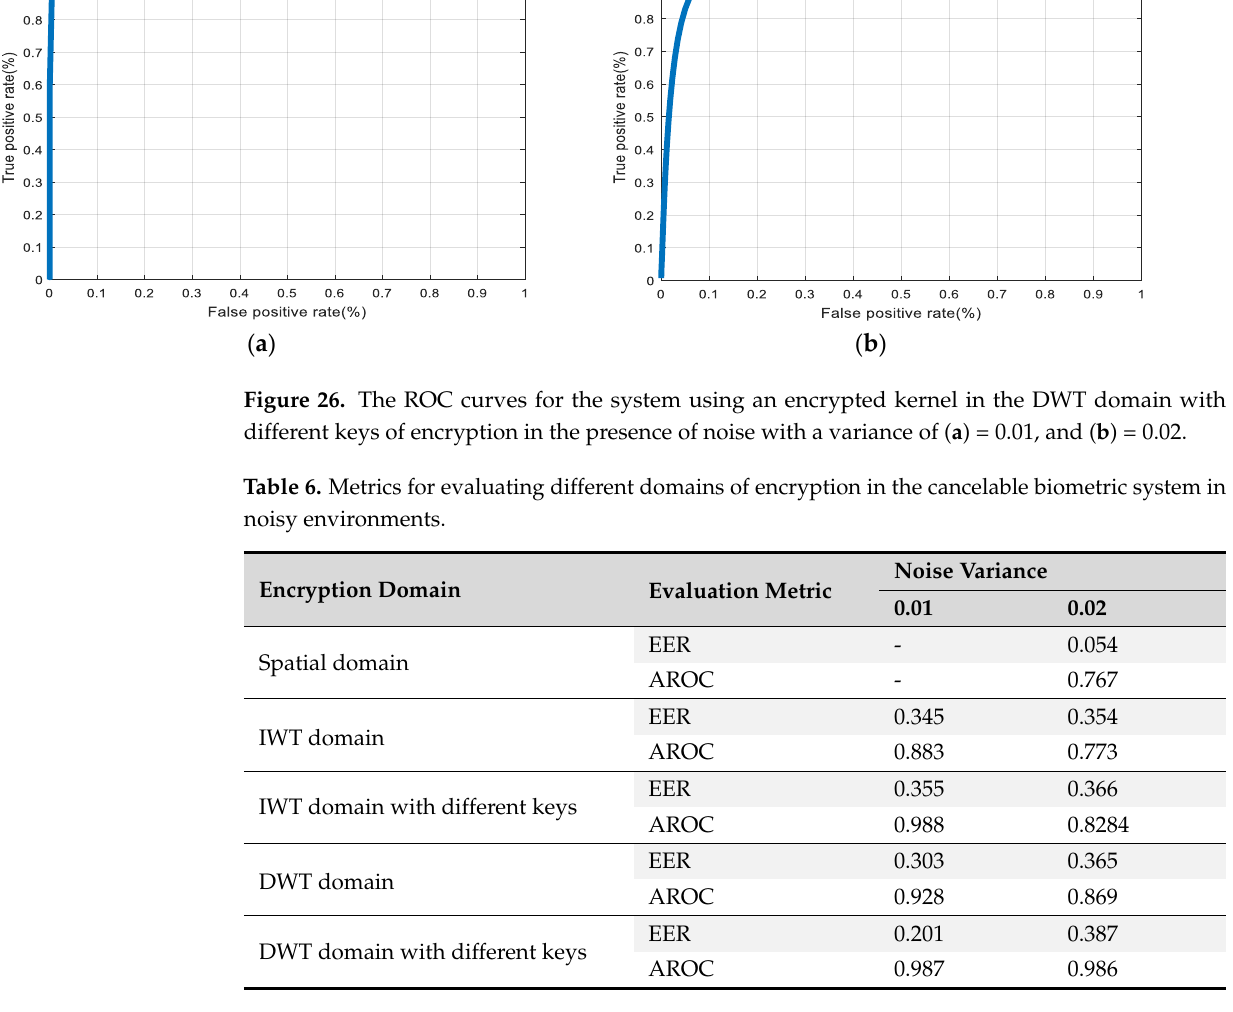
different keys of encryption in the presence of noise with a variance of ( a ) = 0.01, and ( b ) = 0.02.